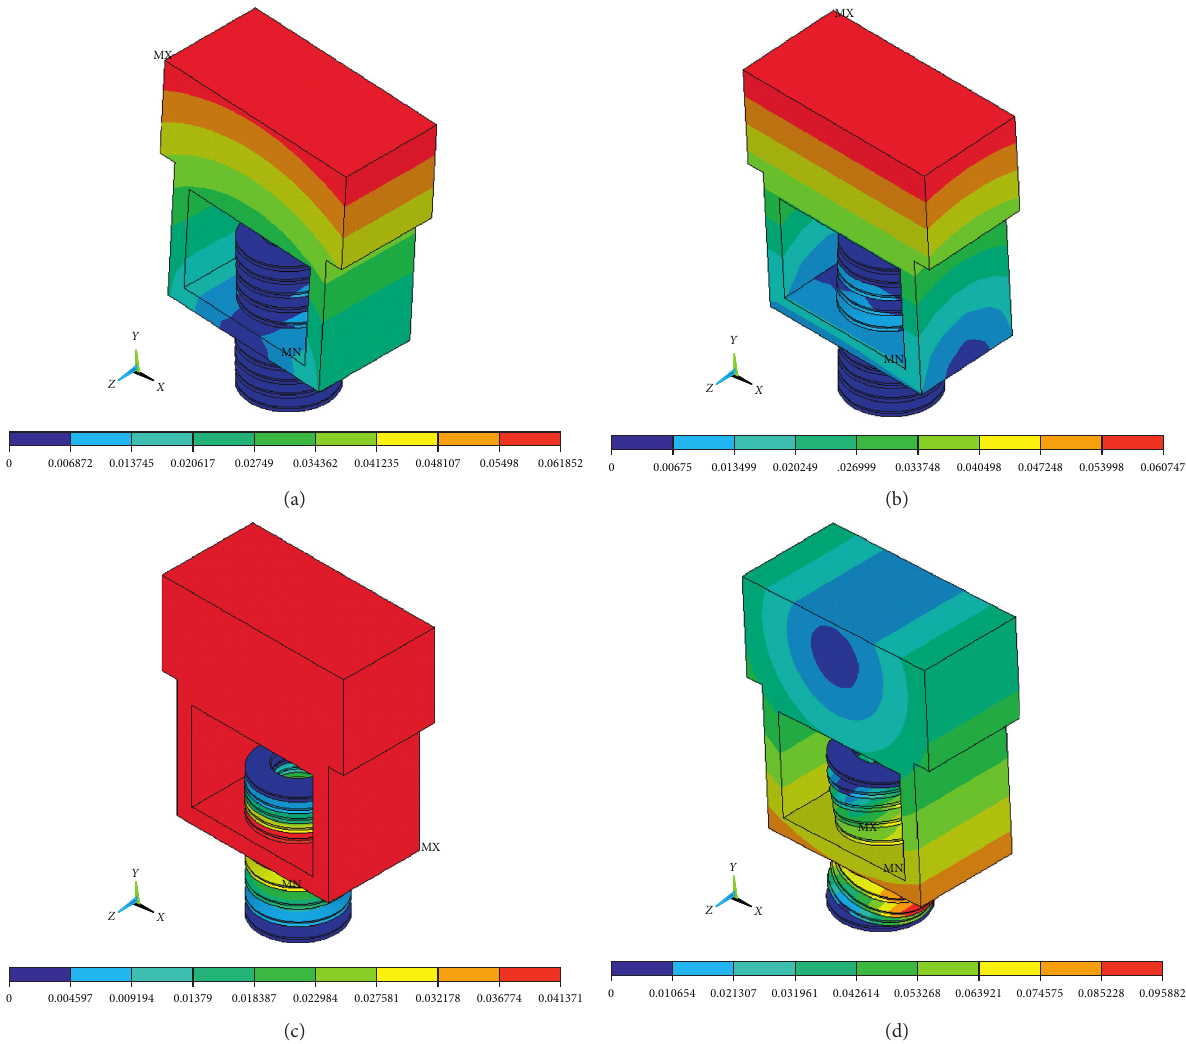
Figure 5: Previous four mode shapes and natural frequencies in